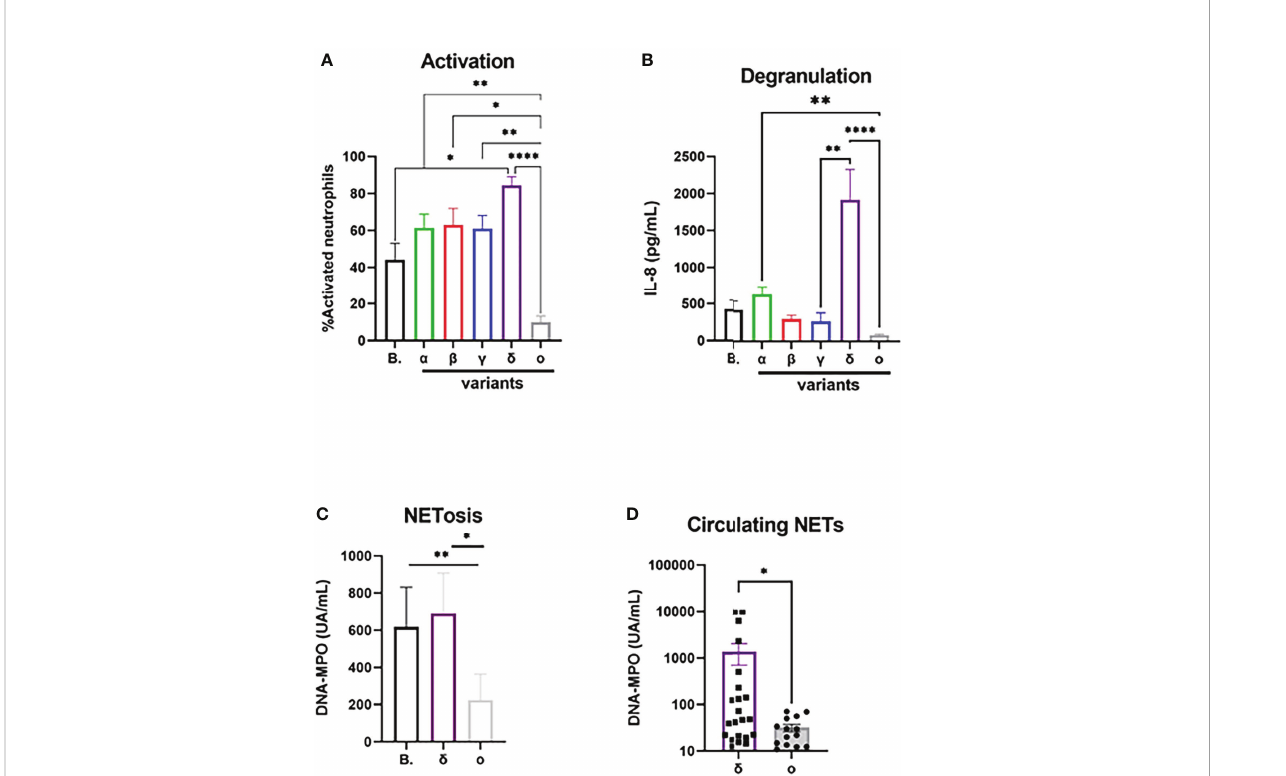
FIGURE 2 Activation potential of neutrophils differ between SARS-CoV-2 variants. (A) Percentage of CD11bhigh/CD62Llow activated neutrophils after 90 min incubation with SARS-CoV-2 “ Wuhan ” strain B and its major VOCs after normalization for medium (n=12). (B) Concentration of IL-8 in supernatant after 90 min incubation with SARS-CoV-2 after normalization for medium (n=12). (C) Concentration of DNA-MPO complexes in supernatant of isolated neutrophils after 3h of incubation with SARS-CoV-2 virus after normalization for medium (n=12). (D) Circulating concentration of DNA- MPO complexes in patients infected with Delta (n=22) or Omicron strain (n=14). Data are mean ± SEM, *p<0.05; **p<0.01;